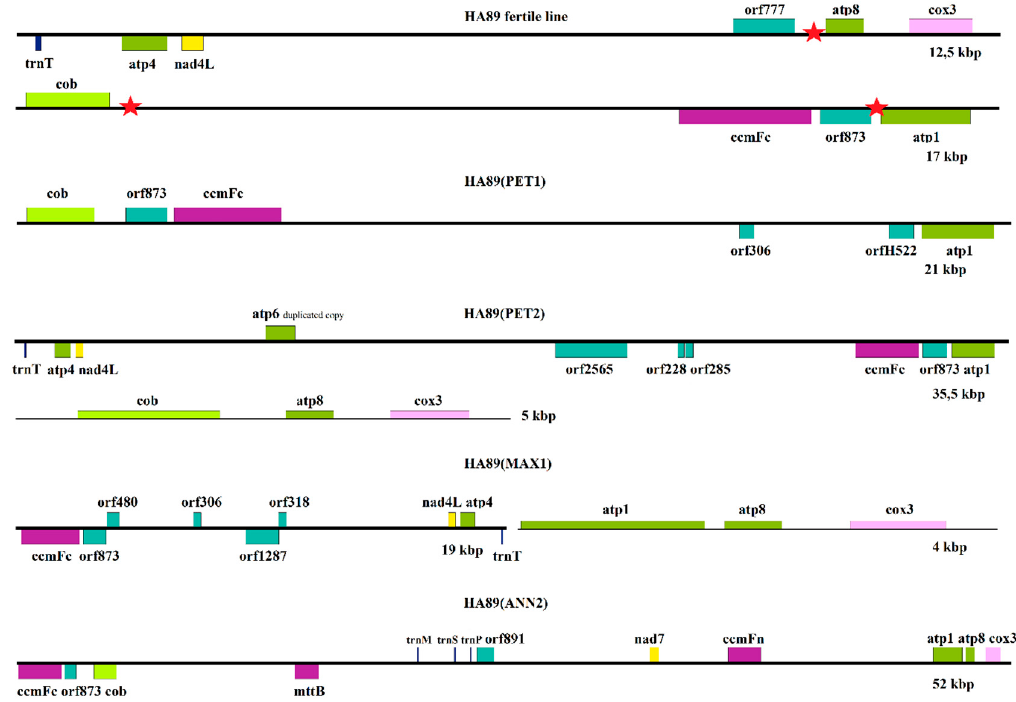
Figure 5. Reorganizations in CMS lines involving the 265 bp repeats (red stars) shown in the male-fertile mtDNA of HA89.